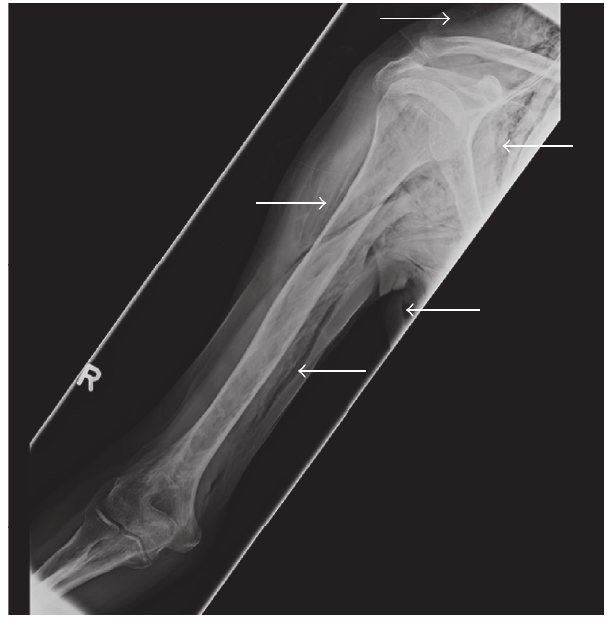
Figure 3: X-ray of the right humeral shaft, indicating emphysema.